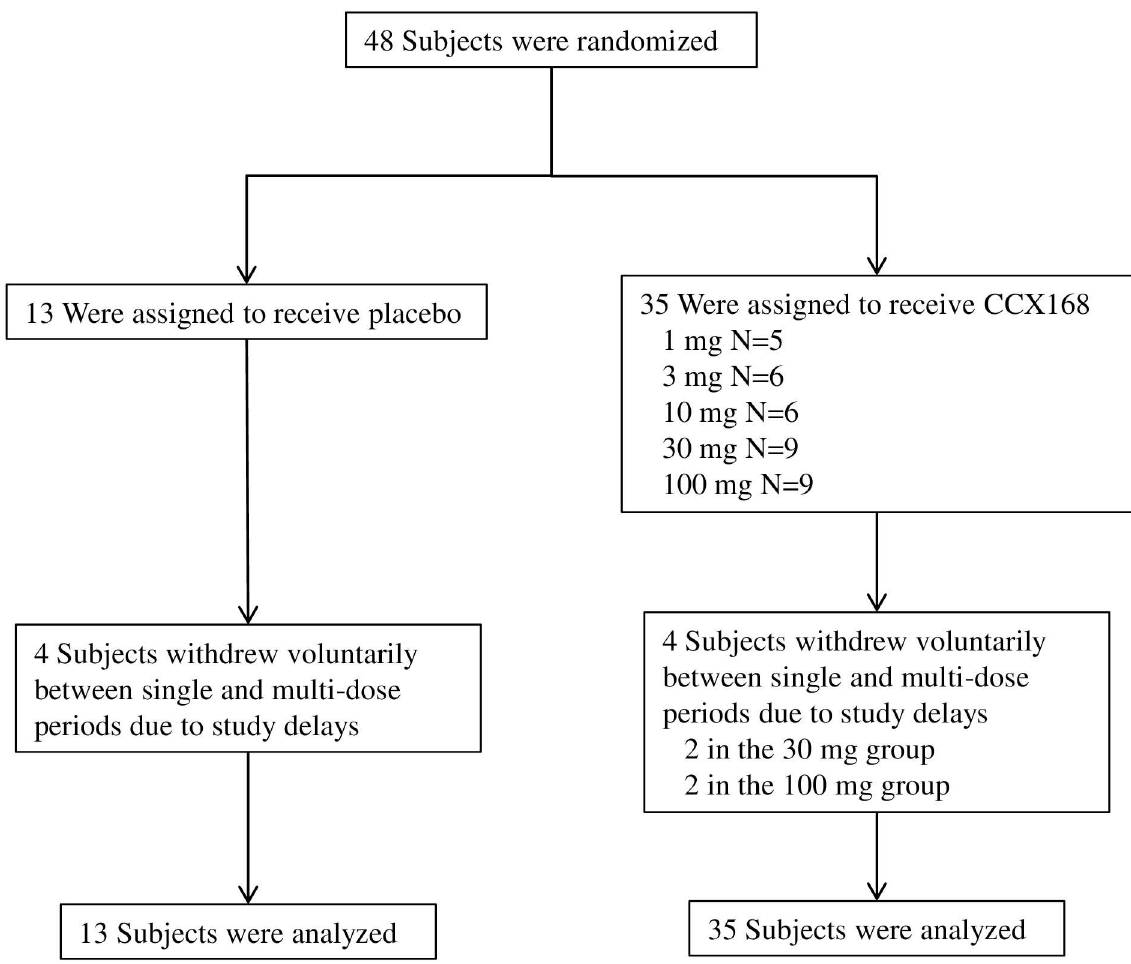
Fig 1. Subject Disposition for Phase 1 Clinical Study.